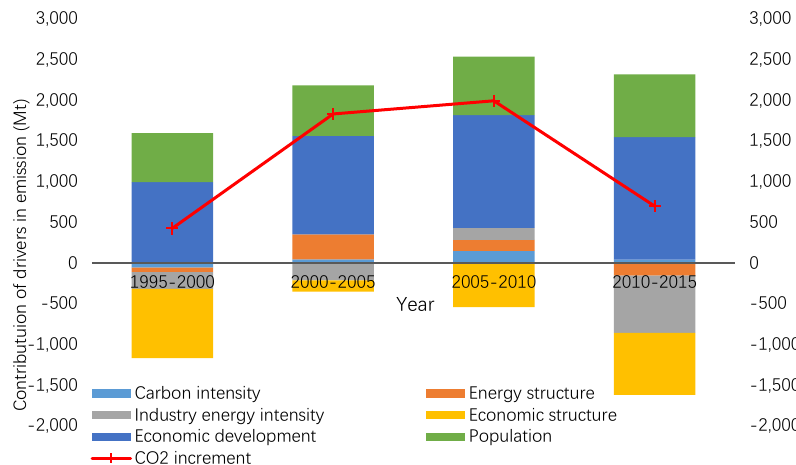
Figure 8. Decomposition of industrial carbon emission from 1995 to 2015.